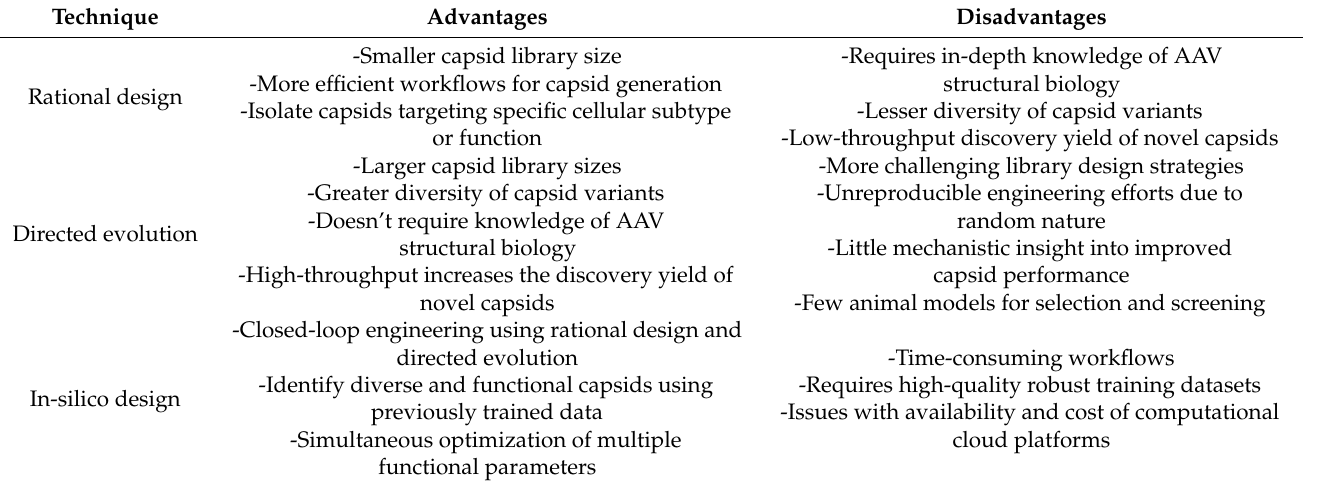
Figure 1. Schematic diagram of capsid engineering to improve CNS trophism. ( A ) Methods for AAV capsid diversification. ( B ) Workflow for capsid engineering, including multi-species selection and tailored enhancement of cellular trophism, immune evasion, and viral packaging. Table 2. Comparison of capsid engineering